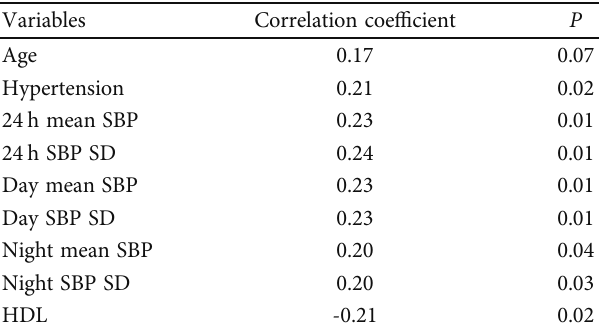
Table 2: Correlations between vascular risk factors and cSVD